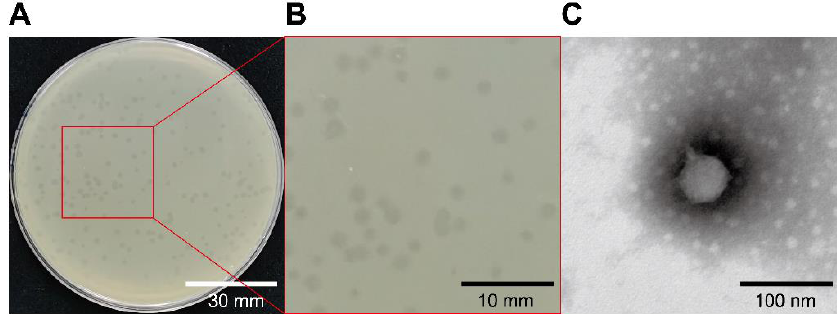
Figure 1. Characterization of vB_VpaP_GHSM17. ( A , B ) Phage plaques; ( C ) transmission electron microscopy.